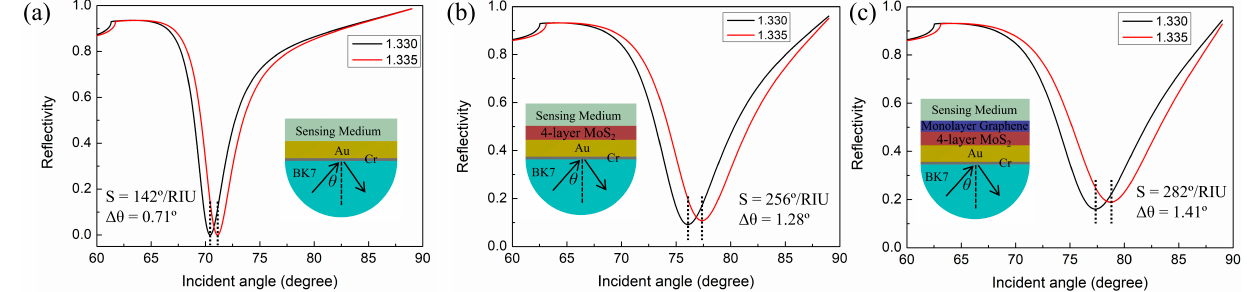
Figure 2. Reflectivity curves change with incident angles for ( a ) conventional Au-based sensor, ( b ) MoS 2 -based sensor, ( c ) graphene–MoS 2 hybrid-structure sensor.